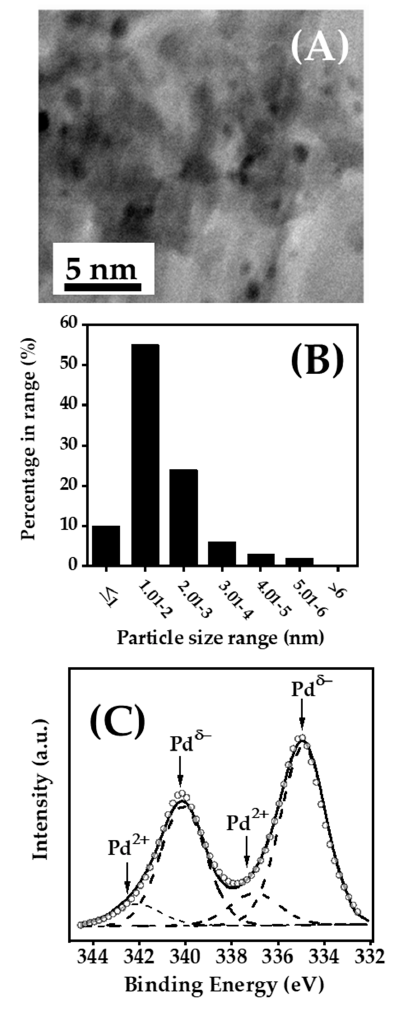
Figure 2. ( A ) Representative scanning transmission electron microscopy (STEM) image with ( B ) associated Pd particle size distribution and ( C ) X-ray photoelectron spectroscopy (XPS) spectrum over the Pd 3 d region for Pd/Al 2 O 3. Note: Raw data is shown as symbols ( ○ ) while curve fitted (residual standard deviation = 0.14) and envelope is represented by dashed and solid lines, respectively.